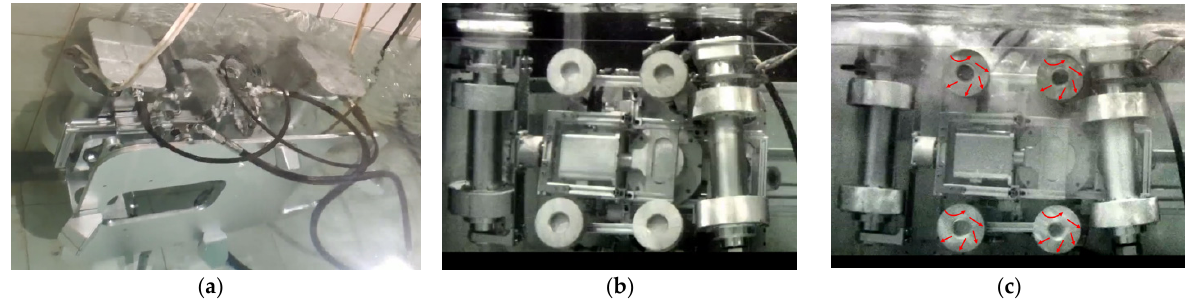
Figure 35. Photos of laboratory pool test: ( a ) photo of wall suction experiment; ( b ) photo of the robot from the back of the glass when the robot was not sucked; ( c ) photo of the robot from the back of the glass when the robot was sucked.